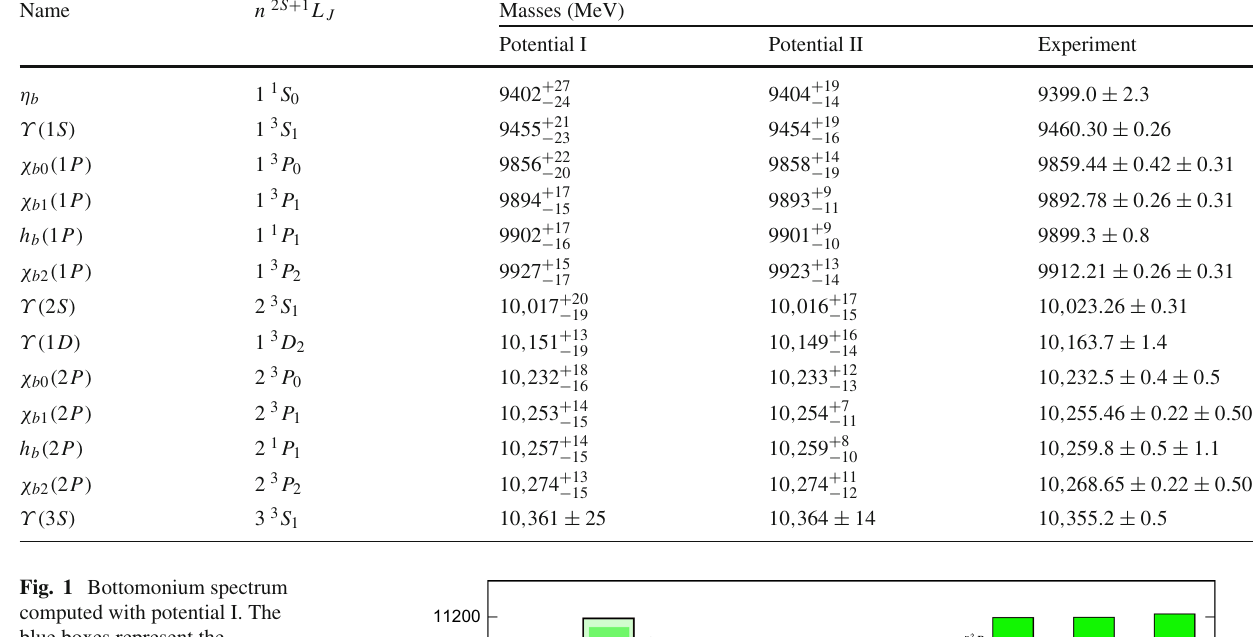
Fig. 1 Bottomonium spectrum computed with potential I. The blue boxes represent the experimental states with their error bands, the purple ones provide the computation of the fitted states. The green boxes represent the predictions of the model and, in particular, those with black edges correspond to missing resonances.